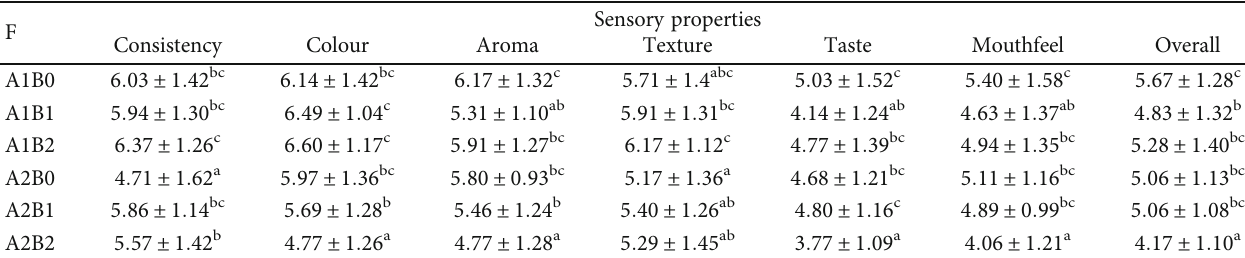
Table 2: Sensory properties of cream soup formulas.